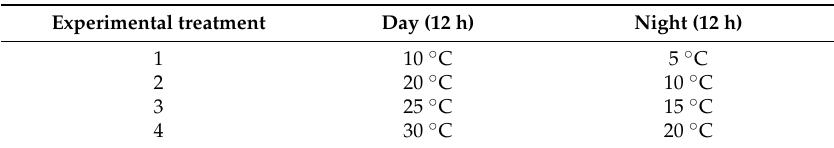
Table 5. Design of the temperature experiment exposing P. schreberi and R. lanuginosum to four different temperature treatments ex situ . Photoperiod and day/night temperature were 12 h